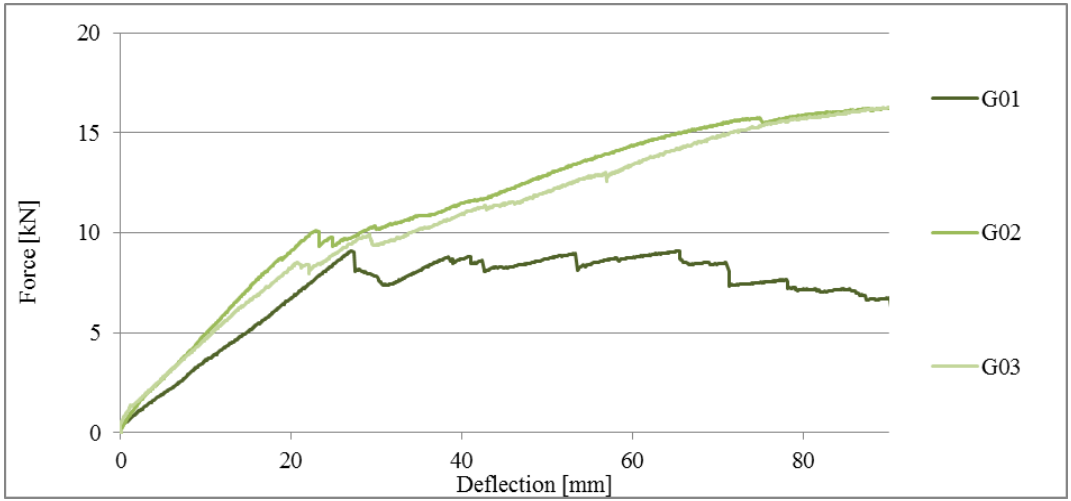
Figure 16. Load-deflection plots for beams in series A, E, F, and G.